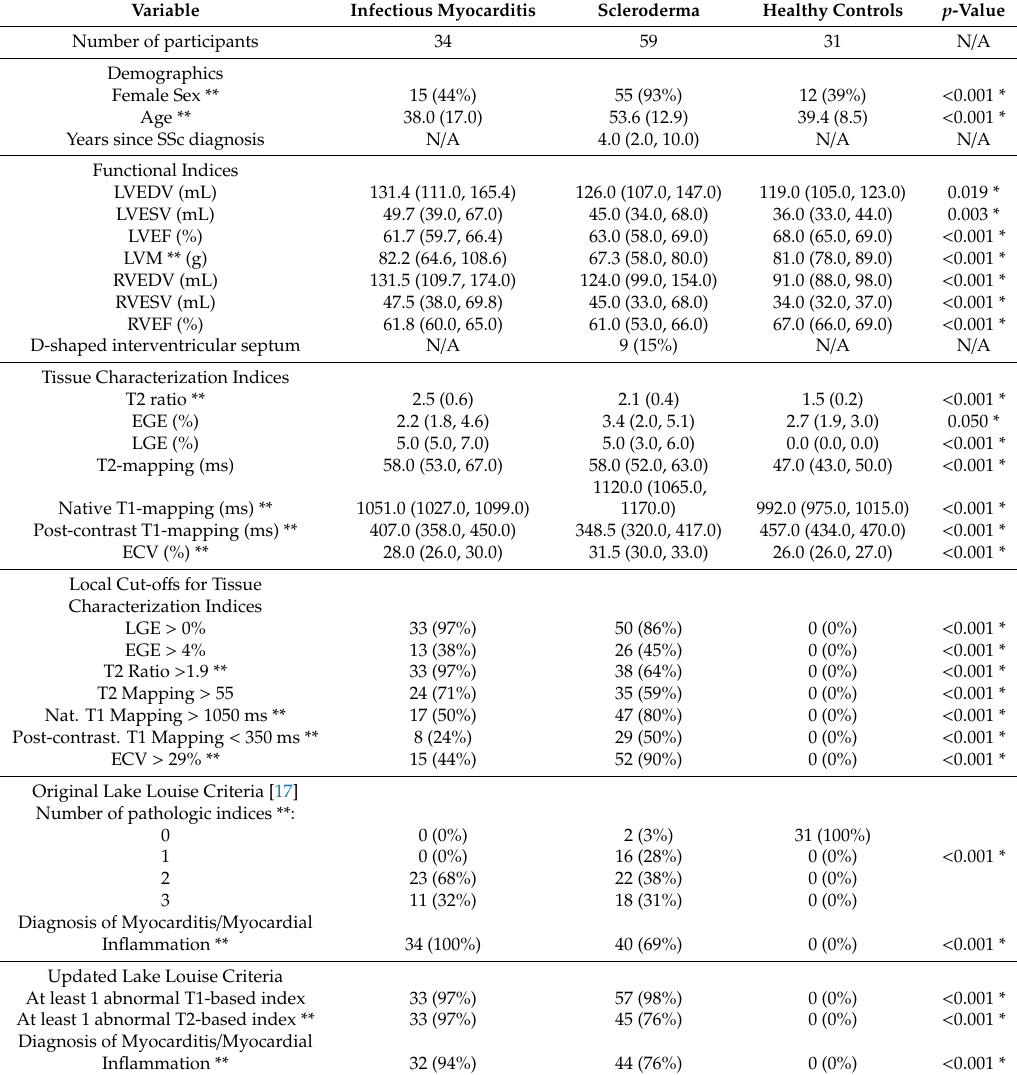
Table 2. Characteristics and descriptive statistics for the whole cohort in subgroups (infectious myocarditis, SSc, controls). Statistical significance for univariate statistical testing is